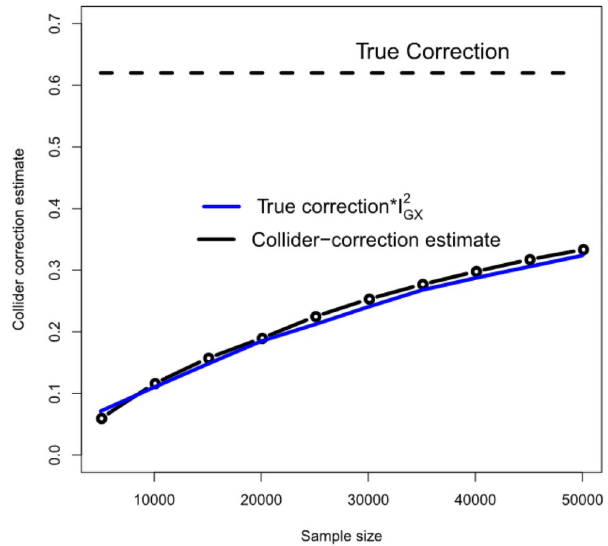
Fig 11. An illustration that the Collider-Correction slope’s dilution can be accurately predicted using the I 2 statistic.